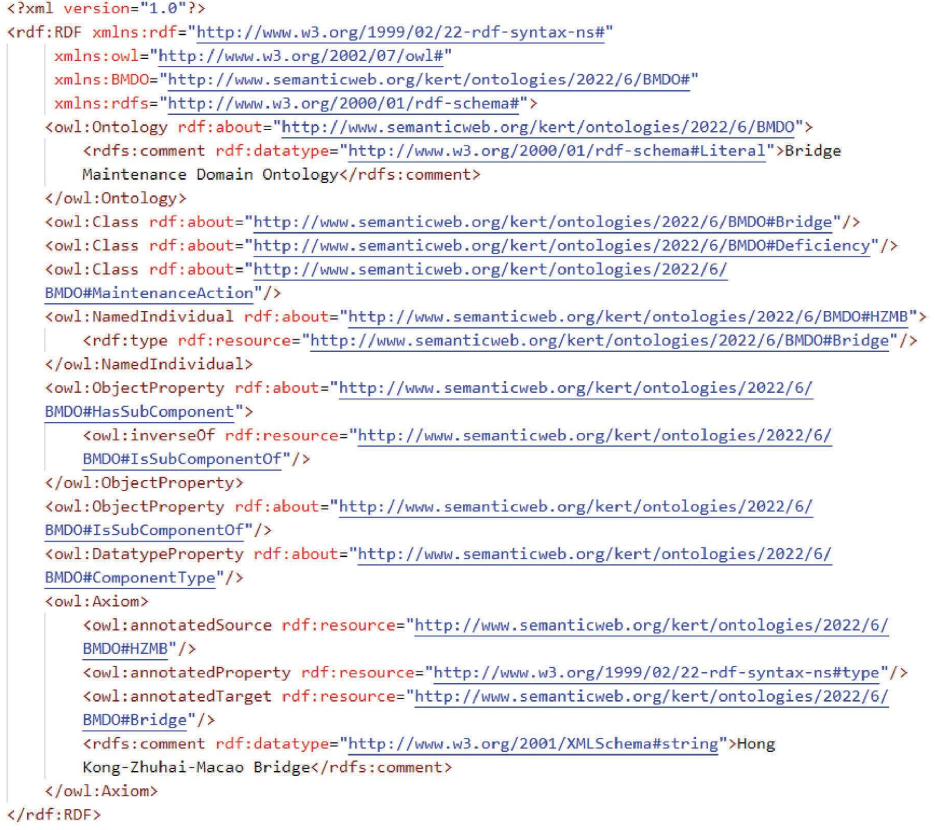
Figure 7: Fragment of the BMDO model coded in OWL